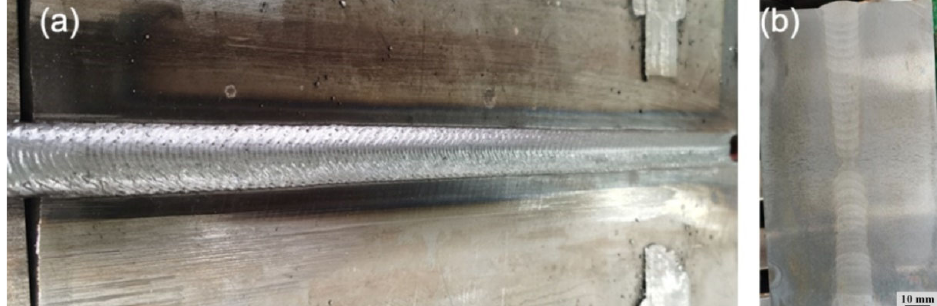
Figure 7. Weld appearance and cross ‐ section of 135 mm ‐ thick welded joint: ( a ) weld appearance; ( b ) cross ‐ section.